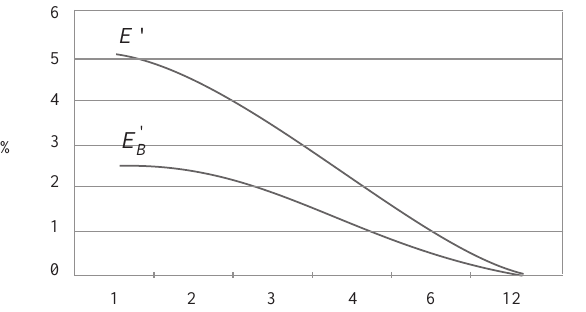
Fig. 3. Dependence of cost price on the number of combined